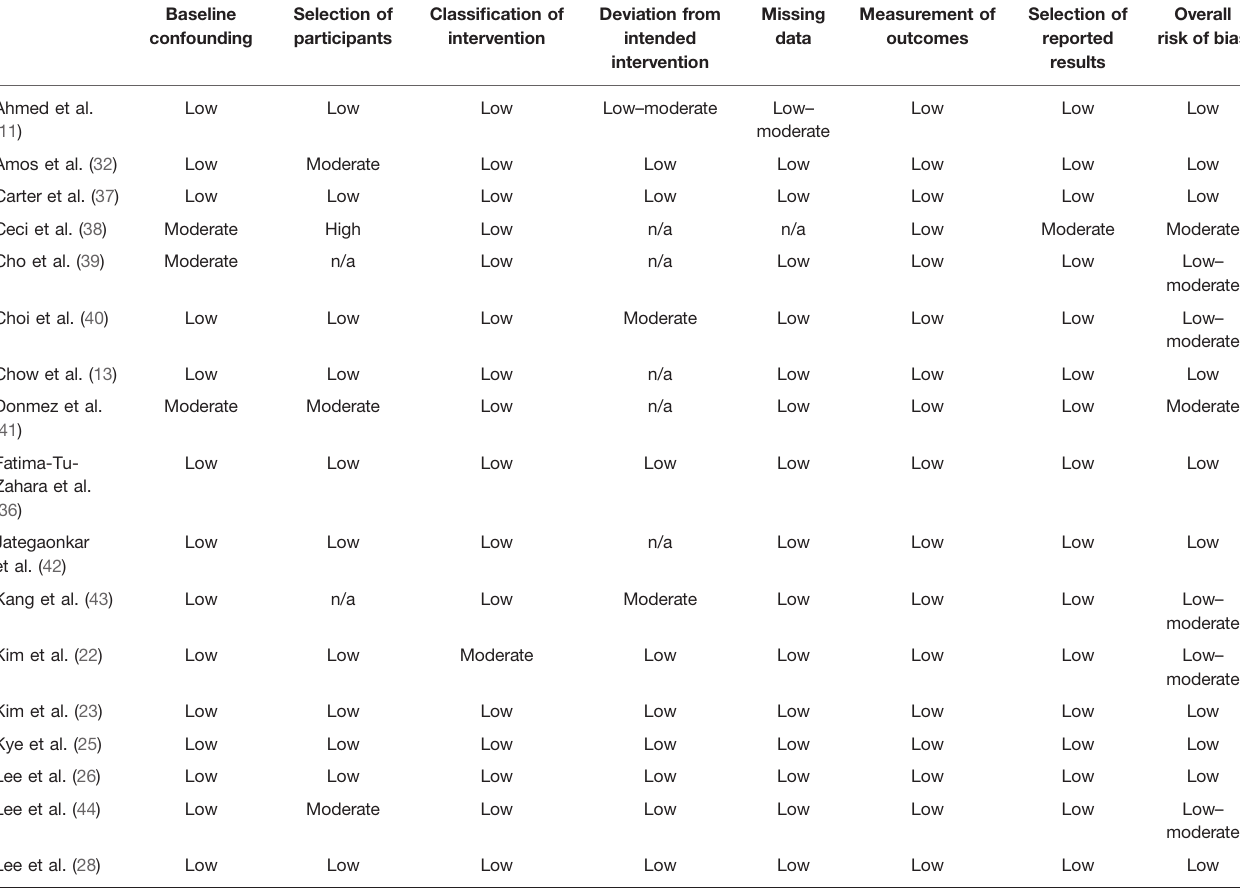
TABLE A1 | Assessment of risk of bias using the ROBINS-I Tool (Risk of Bias in Non-randomized Studies of Intervention). Baseline